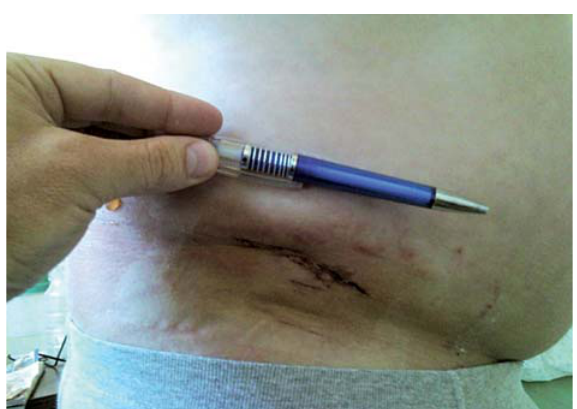
Figure 3 – Groin incision at discharge of patient on postopera- tive day